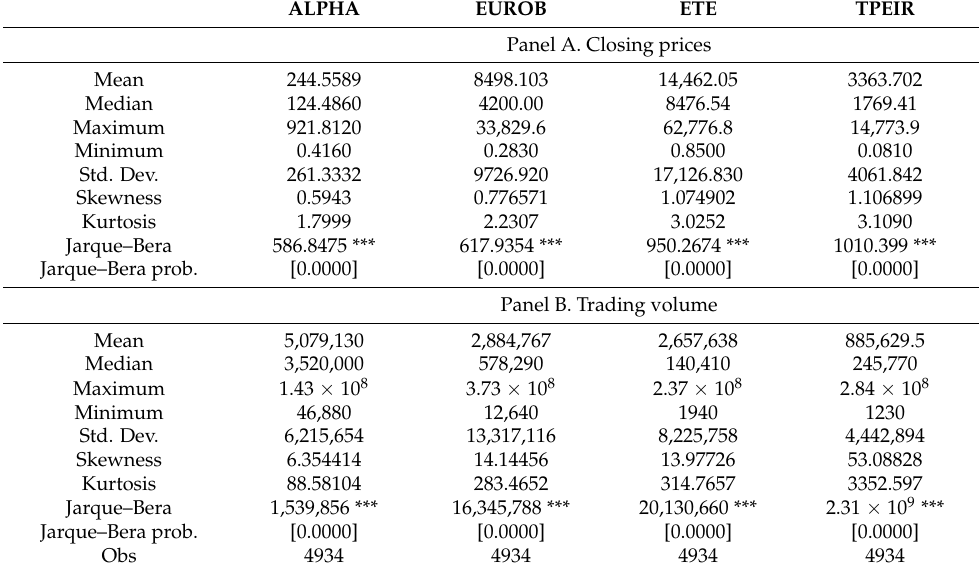
Table 1. Descriptive